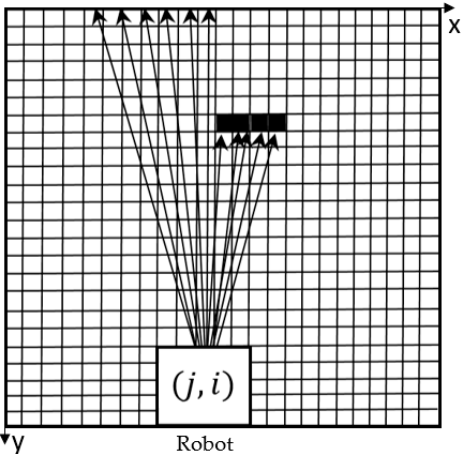
Figure 7. Schematic diagram of obstacles that may be encountered.